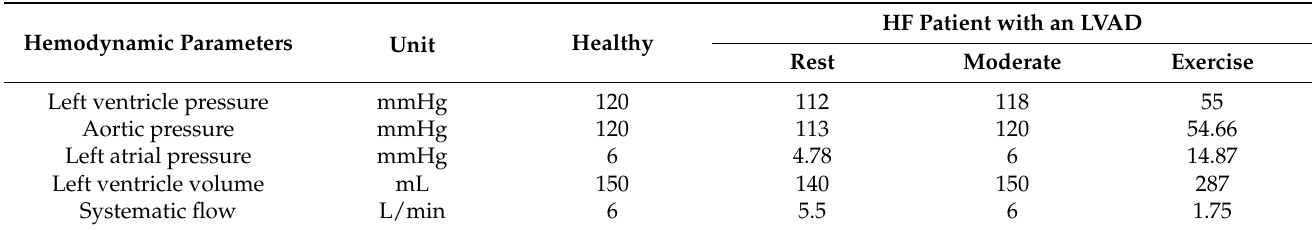
Table 4. CVS hemodynamic parameters in a healthy person and a HF patient with an LVAD.